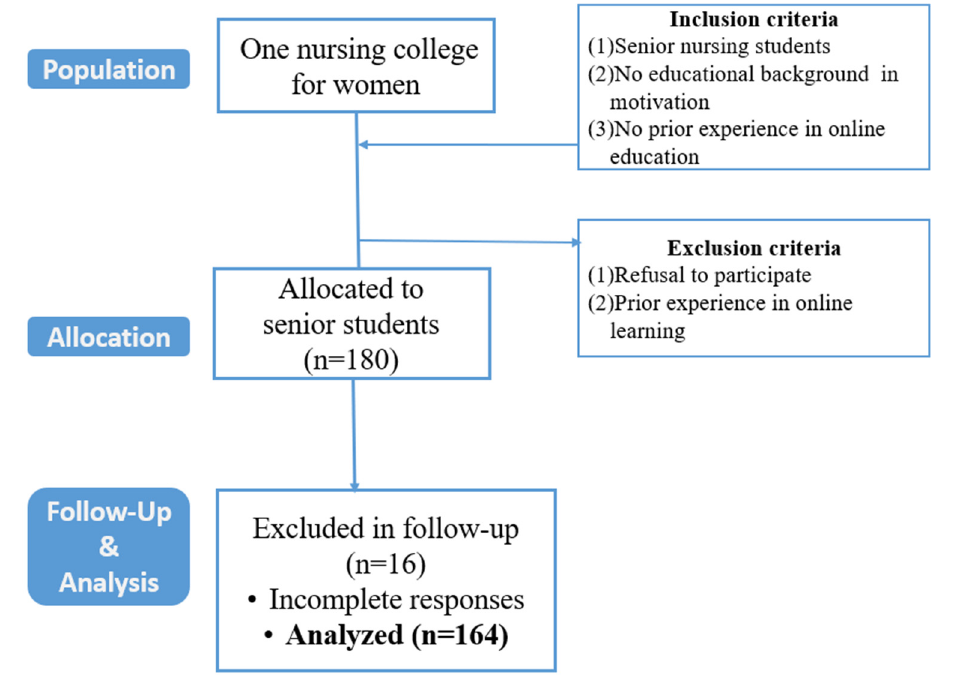
Figure 2. Flow Figure 2. Flow diagram.